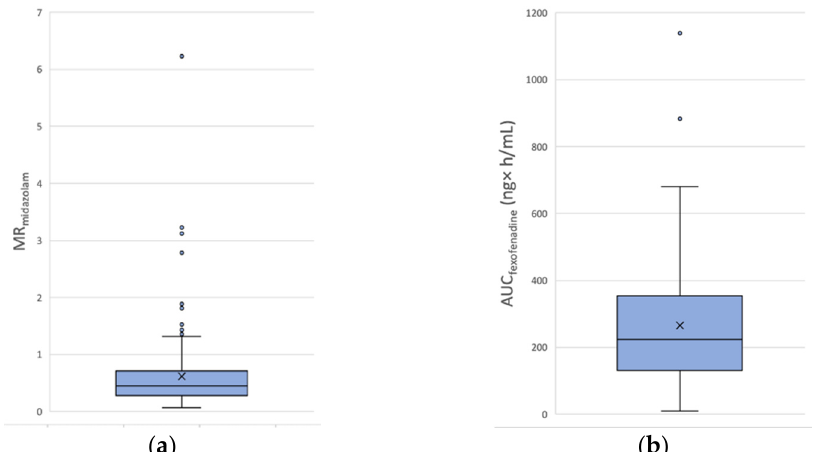
Figure 1. Distribution of phenotype metrics in the apixaban cohort ( a ) MR midazolam and ( b ) AUC fexofenadine.